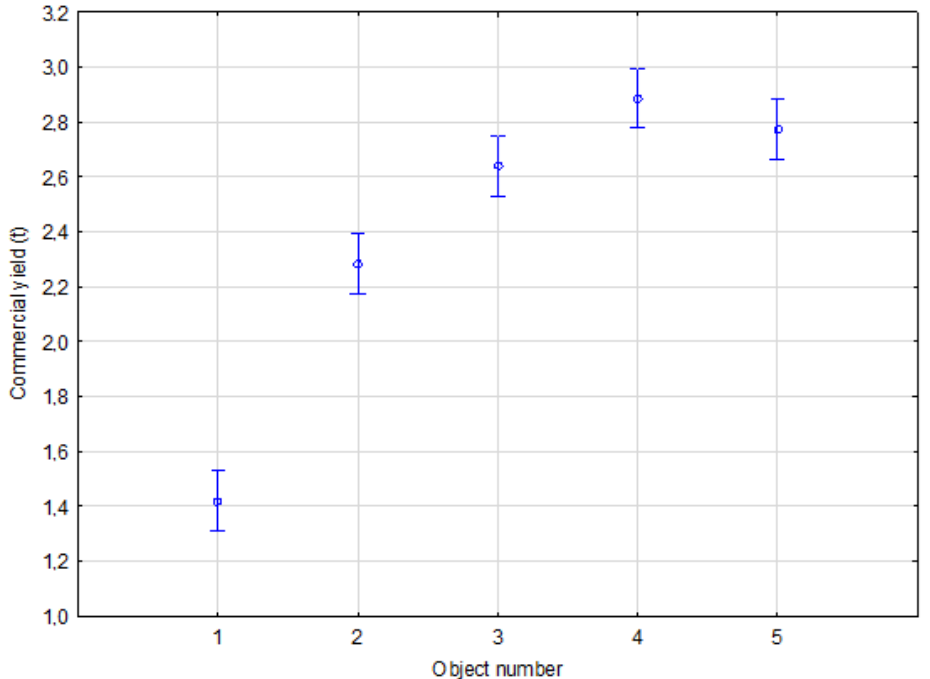
Figure 1. Average values of the marketable yield of beans for the selected fertilization. Different letters mean statistically significant differences at the significance level p = 0.05.